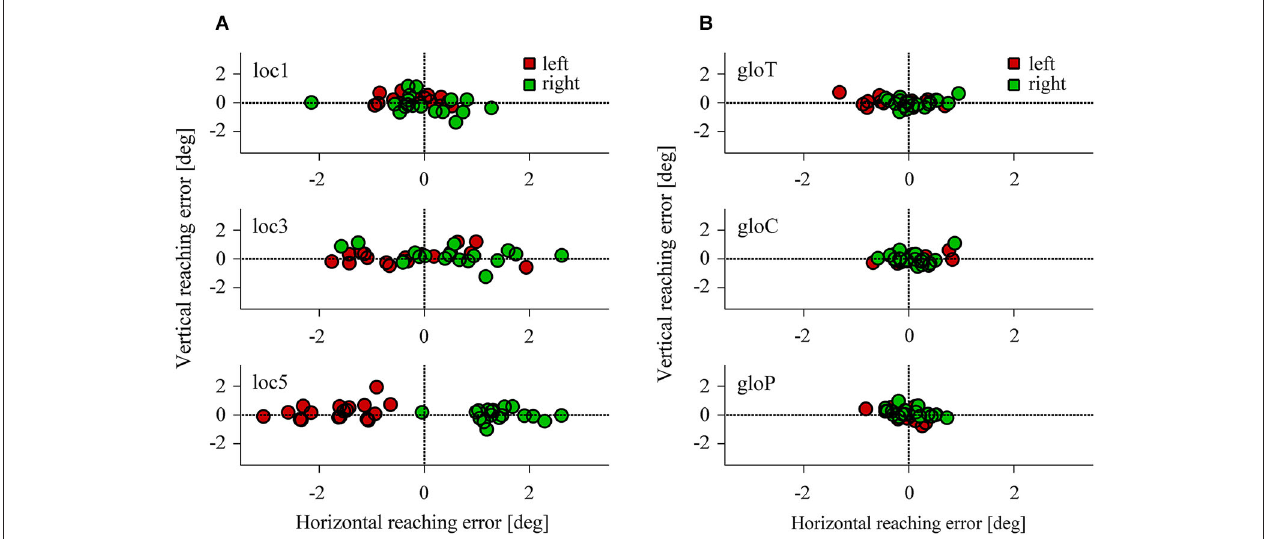
FIGURE 4 | Horizontal and vertical reaching error in the local (A) and the global conditions (B) . Each data point represents the average reaching endpoint for one test image across participants. Red colors indicate a leftward, green colors a rightward target shift.